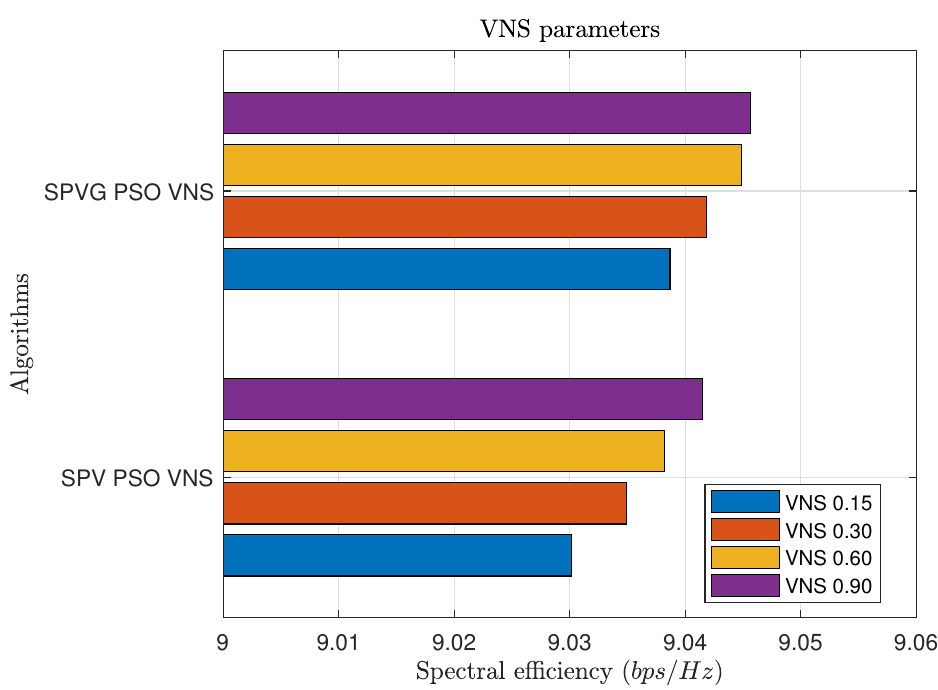
Figure 6. Results of tests to find the better parameters to VNS ( K = 20, R = 1000 m, ( ω ) = 0.25 and v max = 1).